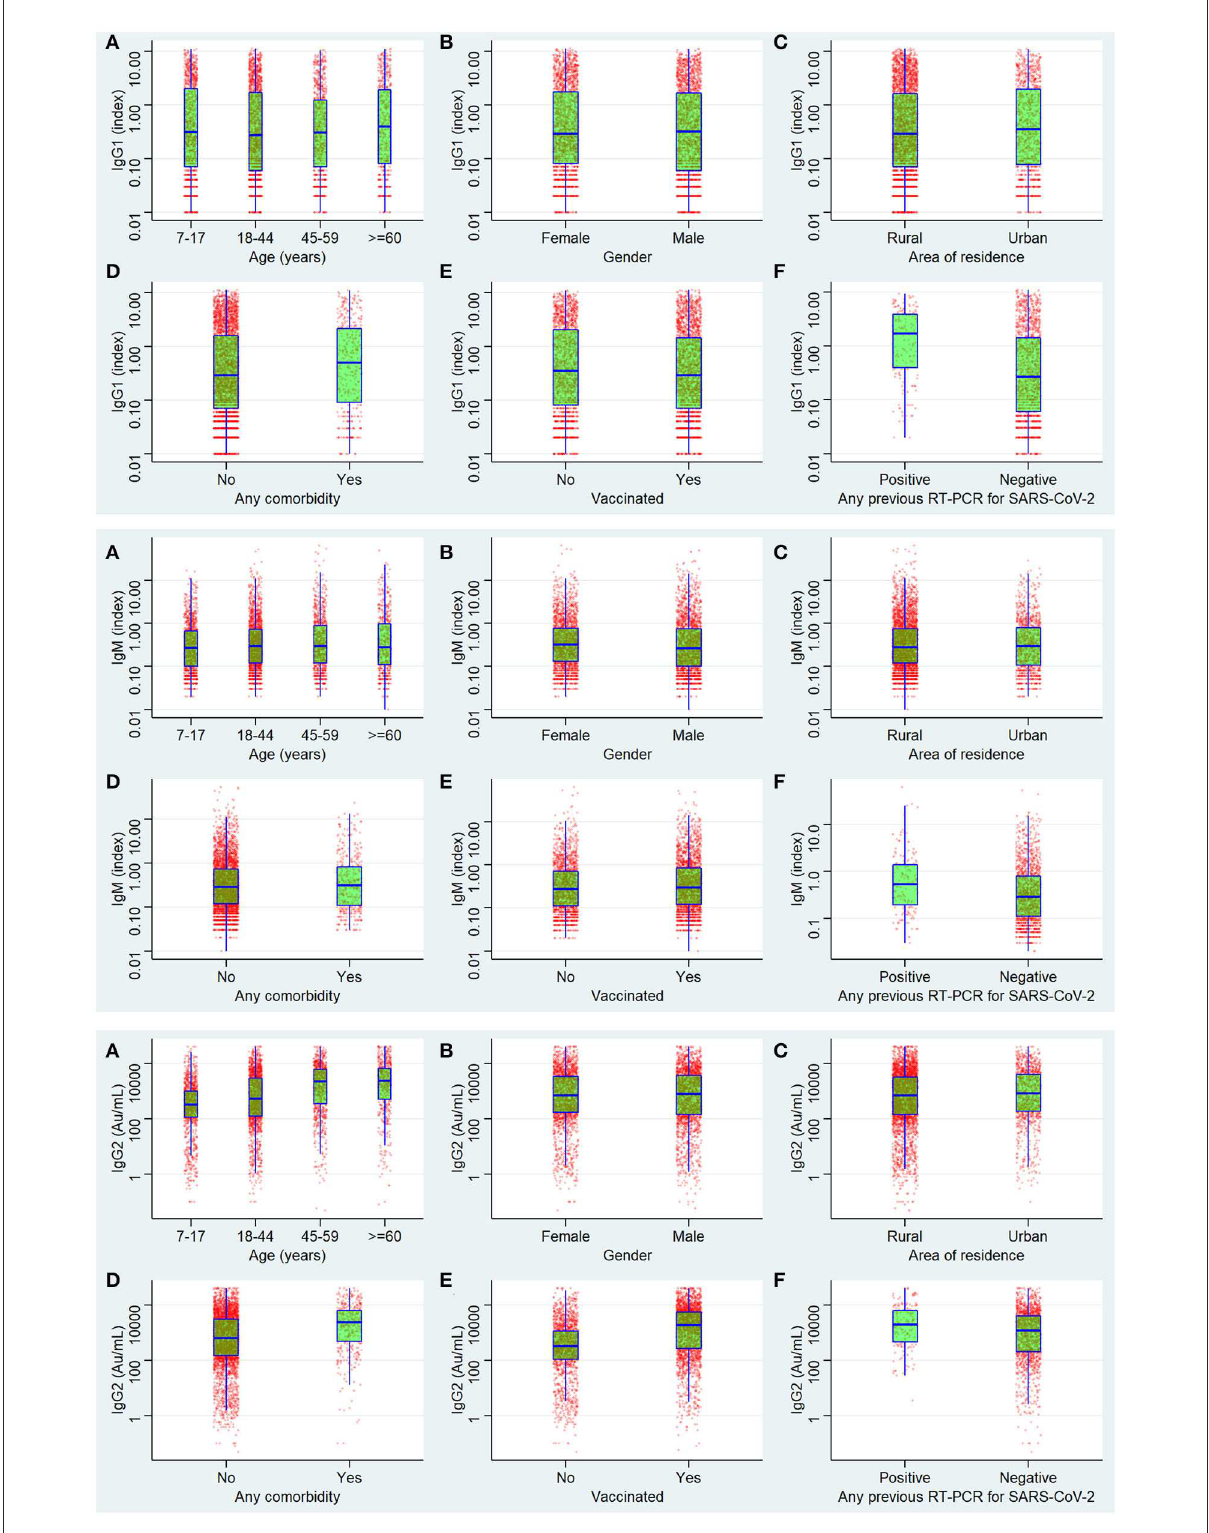
FIGURE4 Antibody levels of IgG1 (anti-nucleocapsid antibody), IgM anti Spike antibodies, and IgG2 (anti-spike